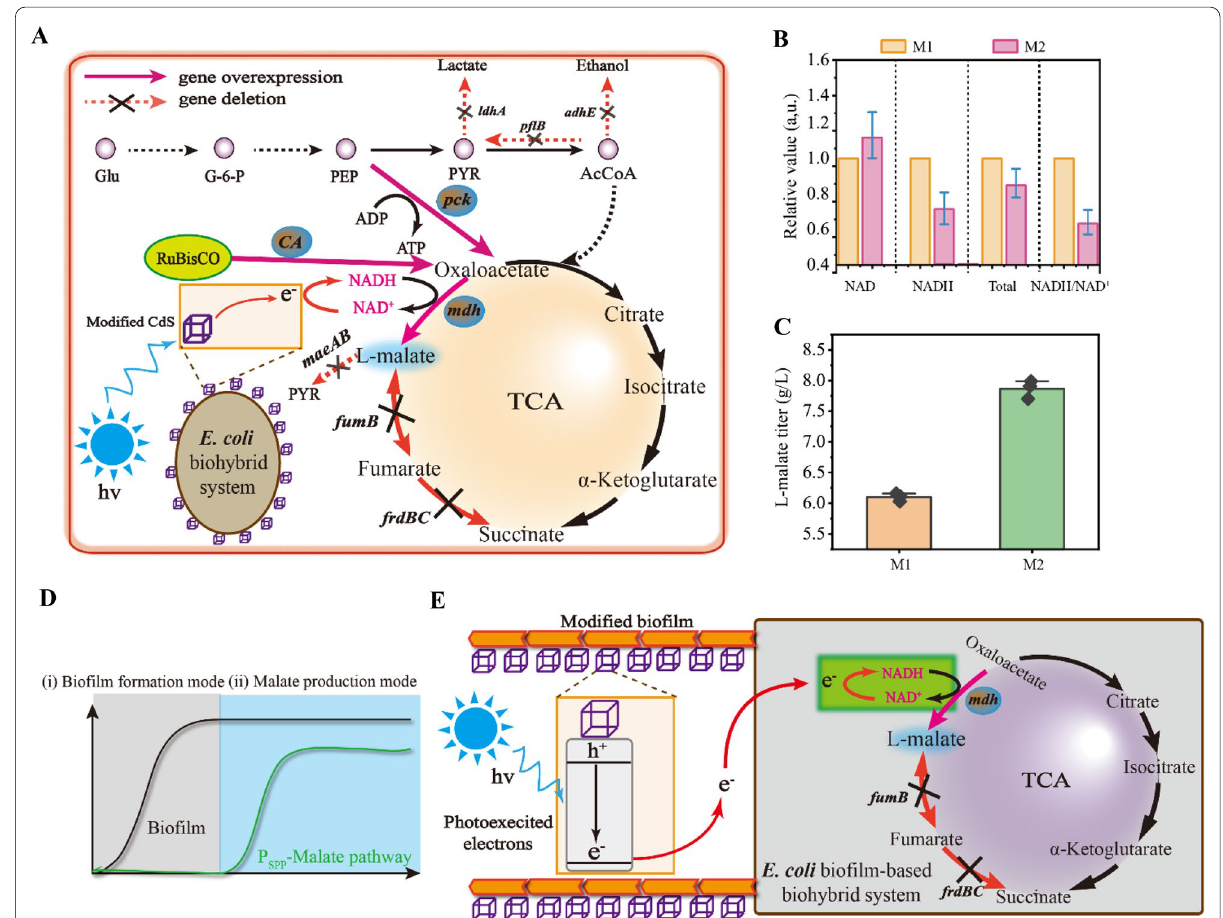
Fig. 5 Engineering L-malate biosynthesis by biofilm biohybrid system. A The schematic diagram of L-malate biosynthesis pathway in E. coli M1. B L-malate titer different strains with biofilm biohybrid system. C Biohybrids system for transporting electricity for NADH regeneration under blue light illumination. D Conceptual graph of two modes fermentation for shikimate production. E Conceptual graph of light-driven biofilm-based biohybrid system with NADH regeneration. For B, C, n 3. Error bars, mean s.d. Each genes: PCK, phosphoenolpyruvate carboxykinase; MDH, L-malate = ±